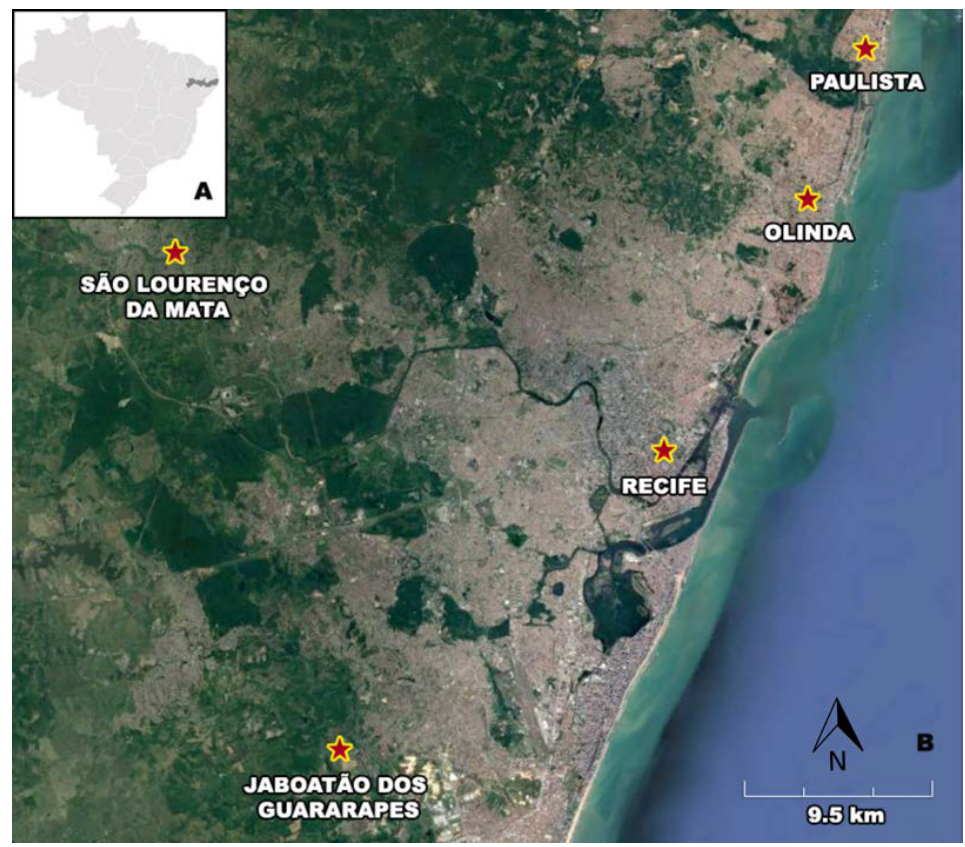
Figure 1. Geographical location and description of mosquito collection sites (red stars) in the metropolitan area of Recife. Legend: ( A ) Map of Brazil, highlighting Pernambuco state and ( B ) five cities from the MAR. Table 1. Location of health care facilities where mosquito collections were performed in Recife, Olinda São Lourenço da Mata, and Jaboatão dos Guararapes.